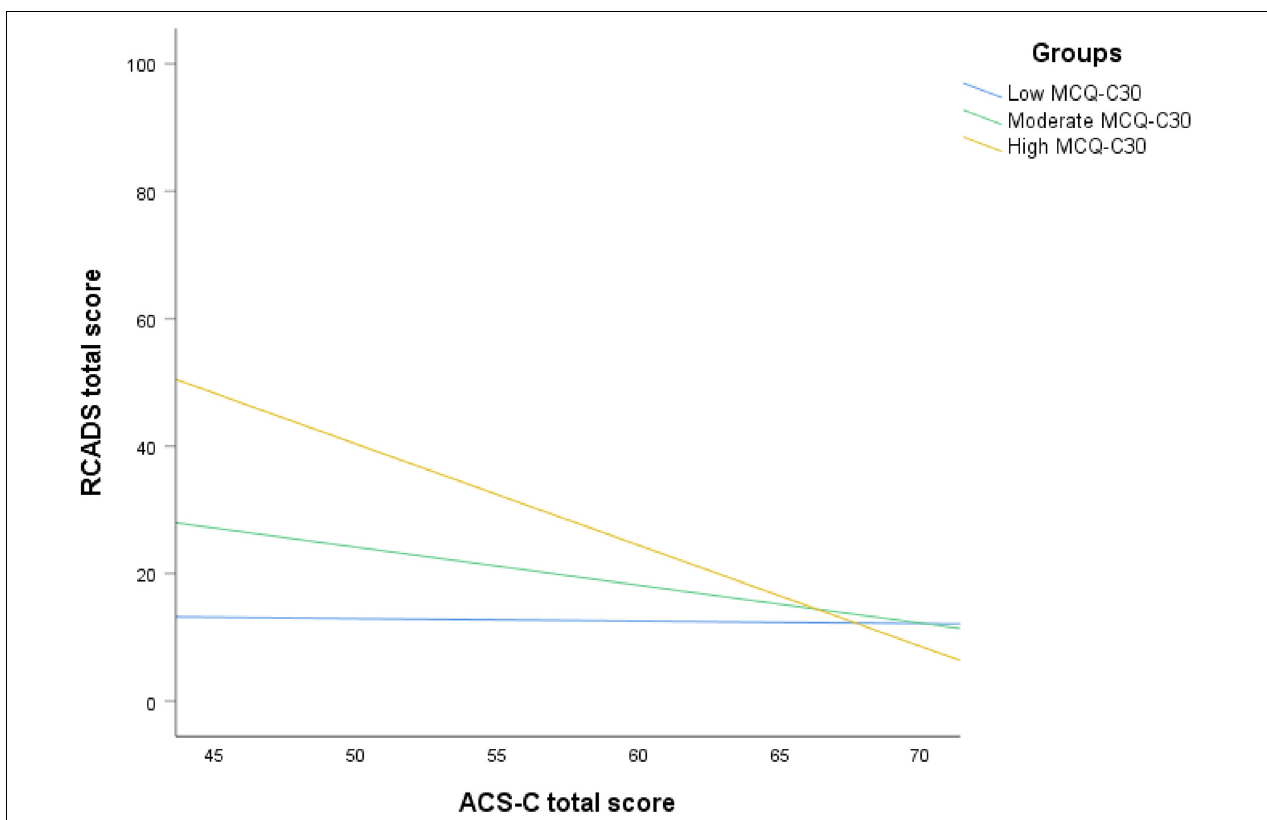
FIGURE 3 | Scatter plot showing the effect of attention control on symptoms at different levels of